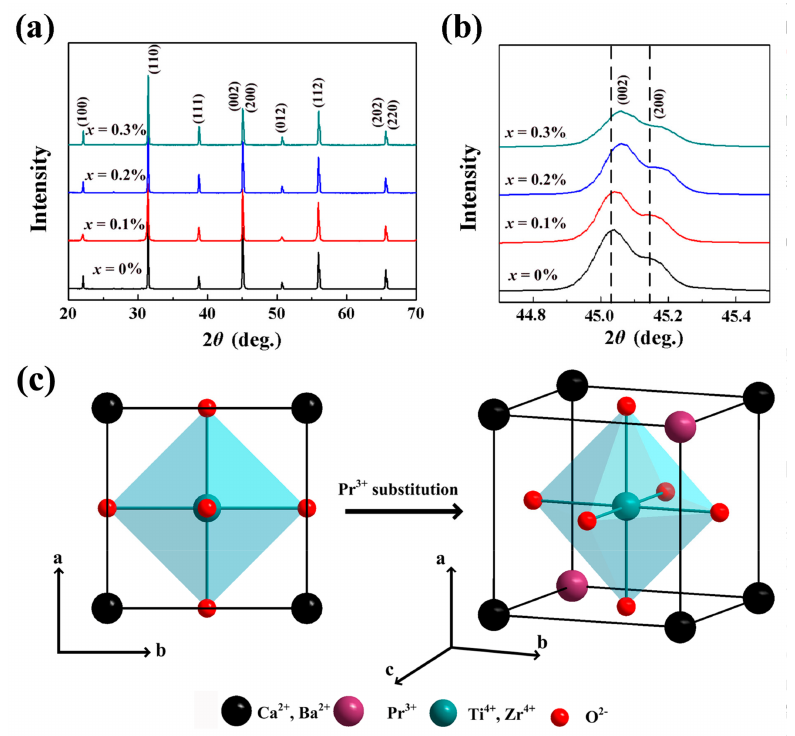
Figure 1. ( a ) XRD patterns and ( b ) (002) and (200) diffraction peaks for the as-obtained BZT-0.5BCT- x Pr 3+ ceramics; ( c ) Schematic illustration for the crystal structure of Pr 3+ -doped BZT-0.5BCT.